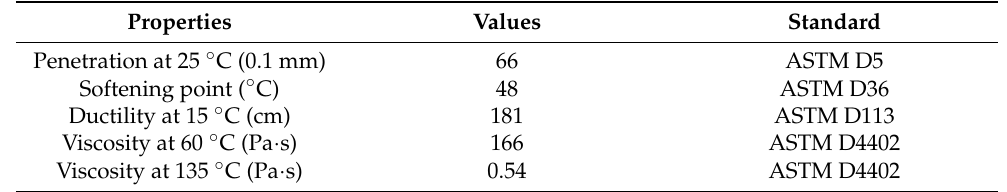
Table 1. Basic properties of base bitumen.